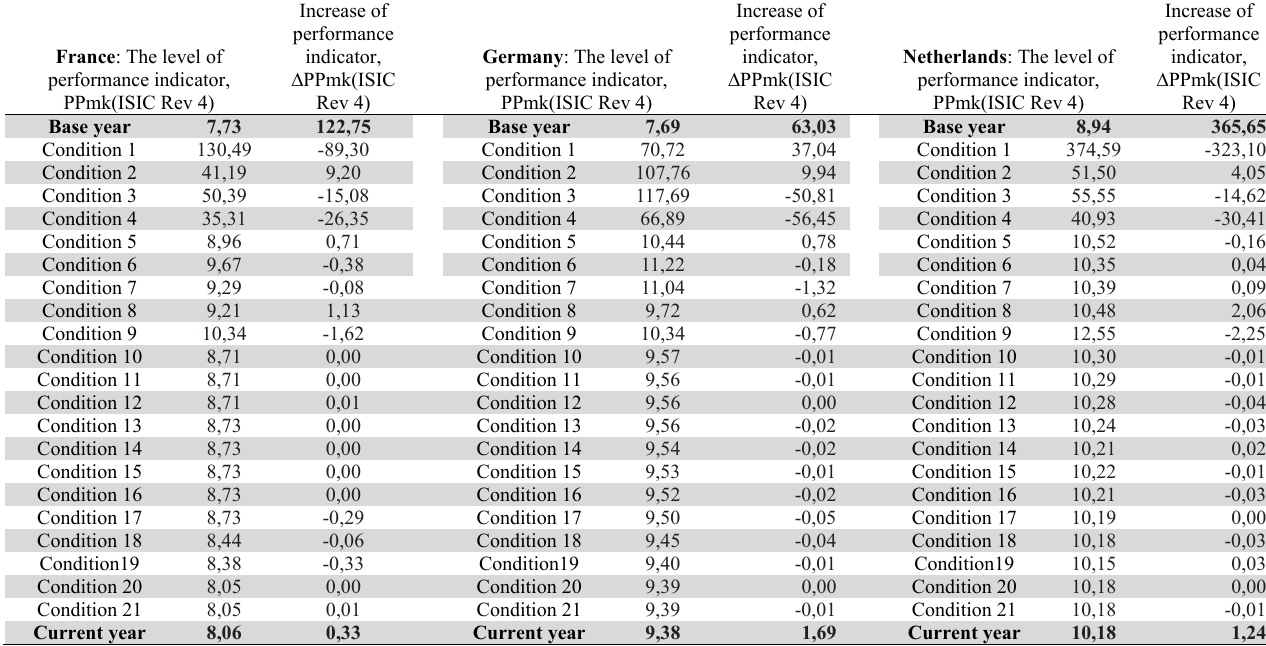
Solving the model of the level of profitability of TNC production in France, Germany, the Netherlands by economic sectors * France : The level of performance